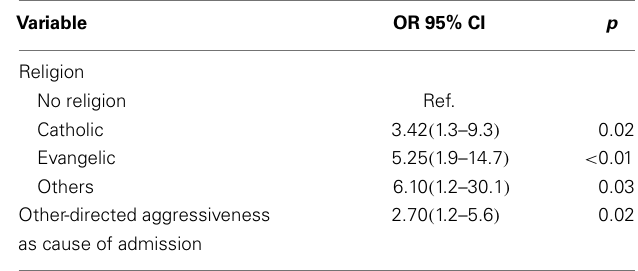
Table 2 | Results from logistic regression (backwardsWALD)